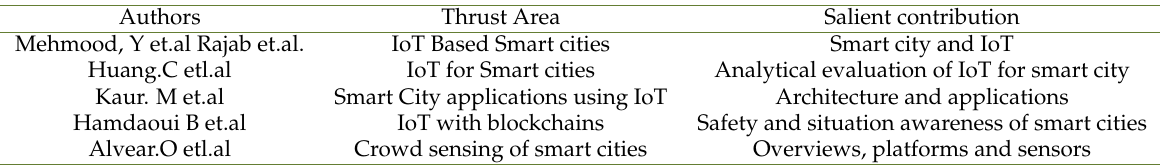
Table 1. Related work by the researchers.